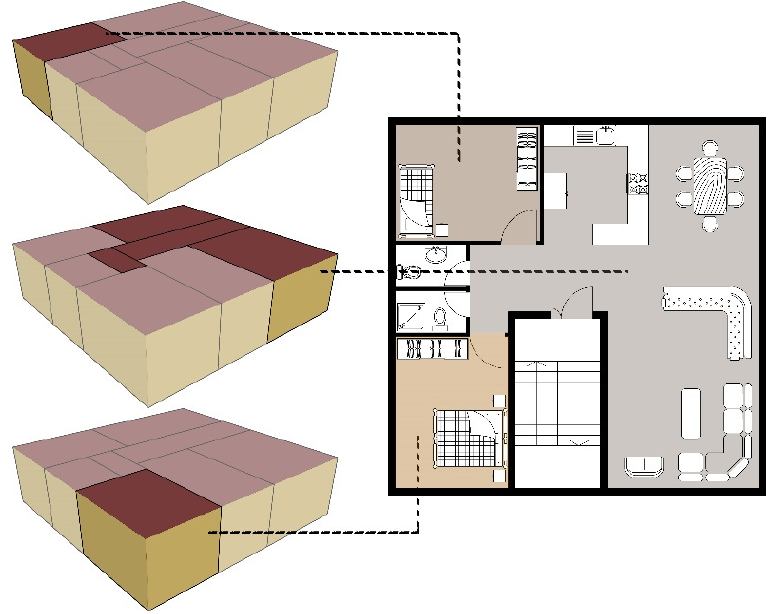
Figure 5. The conditioned zones.